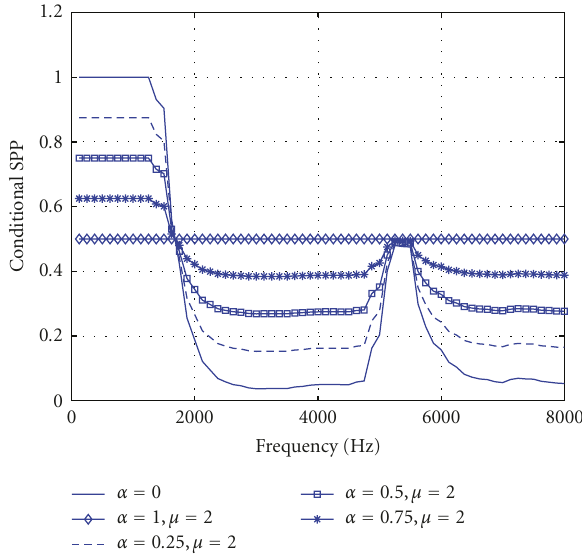
Figure 10: Conditional SPP for the combined solution with high- speech presence at low